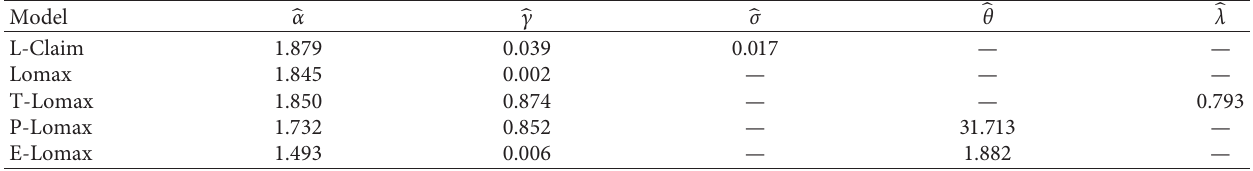
Figure 11: Plots of MLEs, MSEs, biases, and absolute biases for α � 1 . 4 ( green − line ) , c � 0 . 9 ( red − line ) , and σ � 1 . 1 ( blue − line ) . Table 3: The estimated values of the parameters of the fitted distributions.